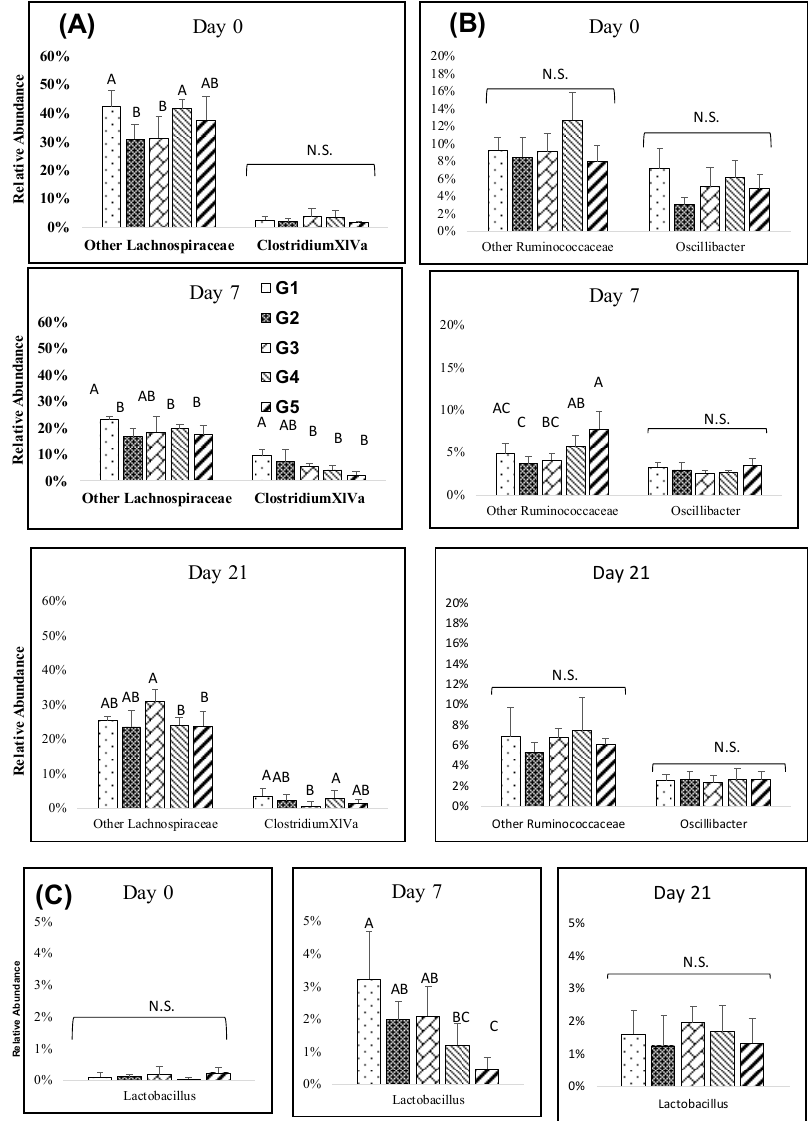
Figure 3. Impact of melanoidin malts on responsive genera relative abundances among the Firmicutes. ( A ) Lachnospiraceae, ( B ) Ruminococcaceae, and ( C ) Lactobacillaceae. Significant differences ( p < 0.005) are indicated by different letters ( n = 5).